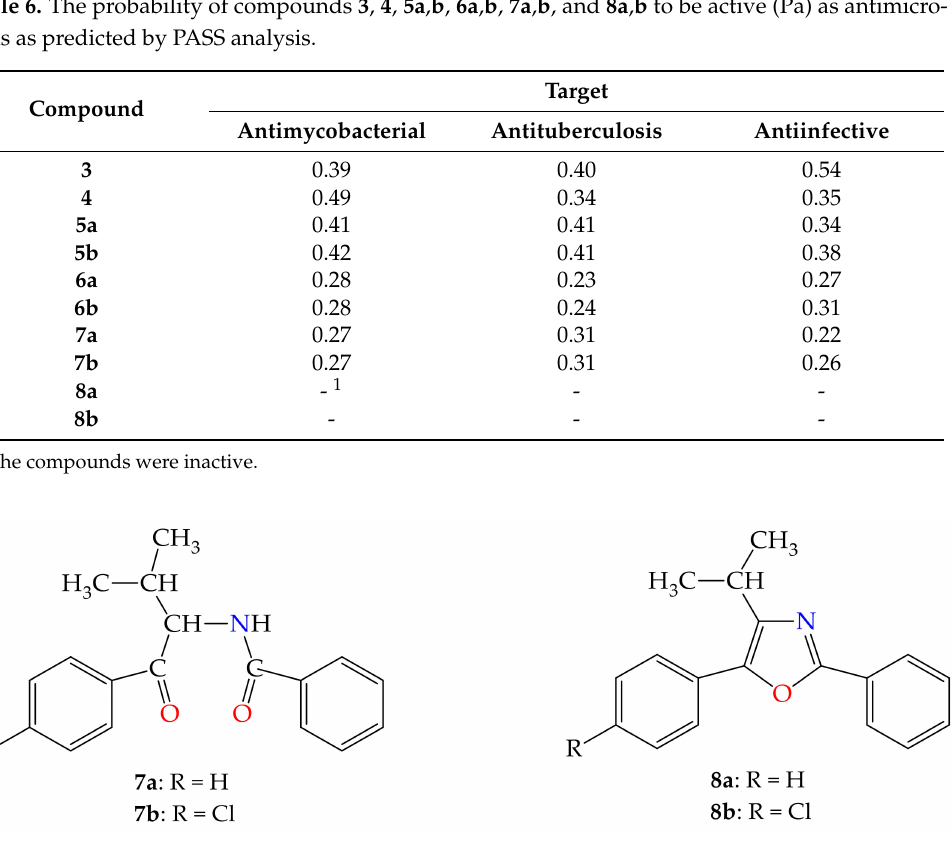
Figure 5. Structures of the designed analogs 7a , b and 8a , b